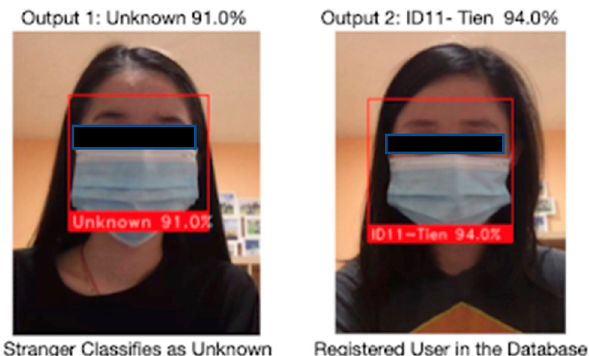
Figure 22. Face Mask Facial Recognition in different scenarios.